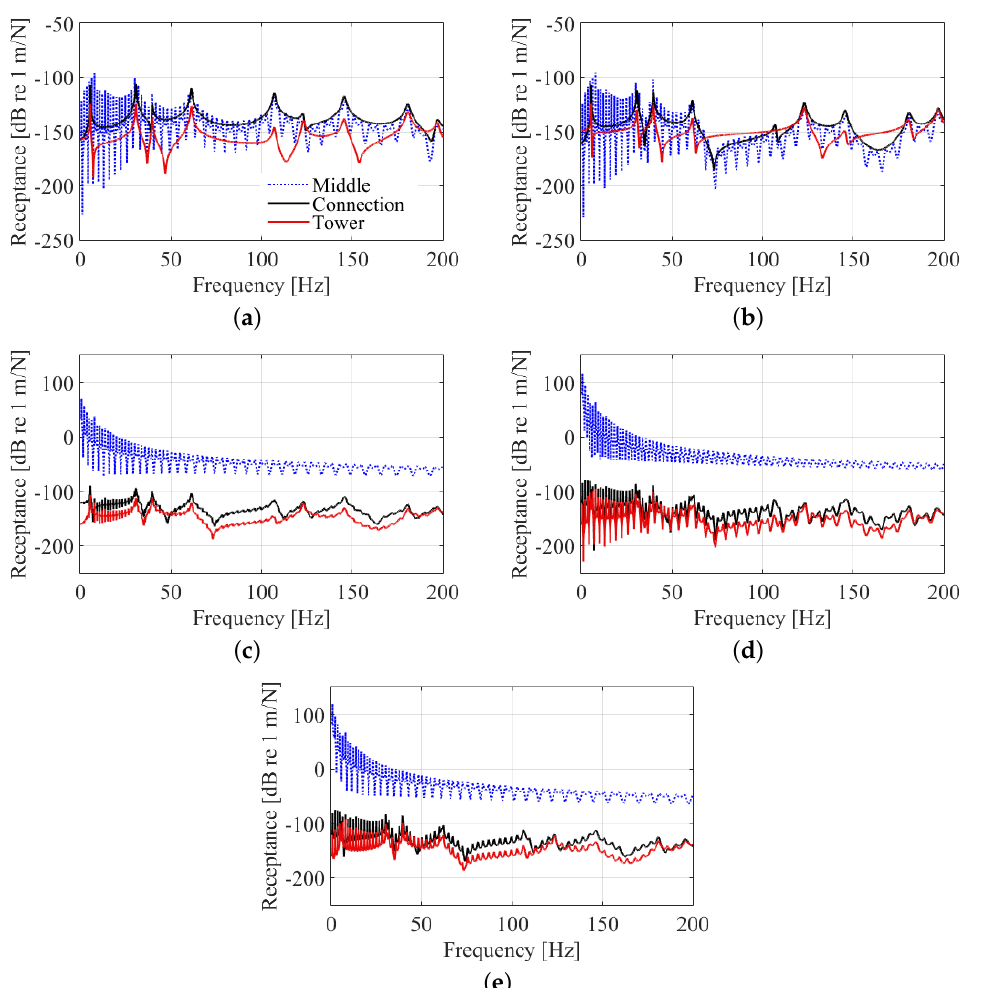
Figure 17. FRFs obtained due to an wind-rain excitation force positioned at the coupling point ‘b‘ (black curves), a meter from the connection in ‘c‘ (red curves), and at the cable middle length in ‘d‘ (blue curves), and estimated at: ( a ) tower, ( b ) tower-cable connection, ( c ) cable 1 m from support, ( d ) cable middle length, ( e ) cable